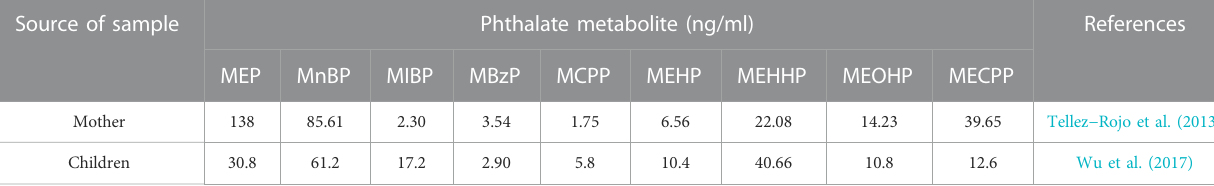
TABLE 1 Concentrations of various phthalate metabolites in urine (SG-corrected, ng/mL). Source of